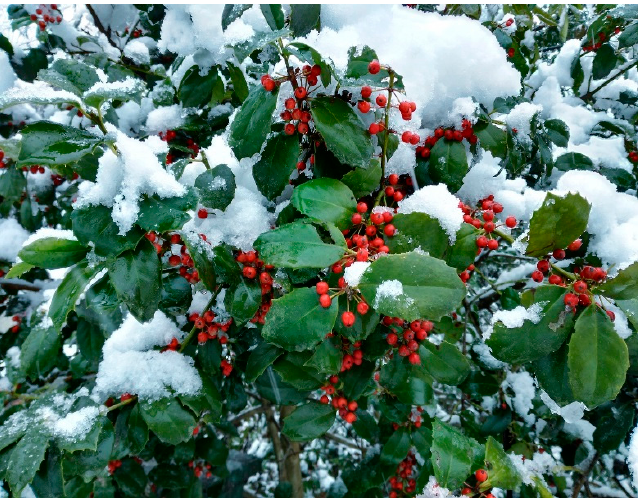
Figure 1. I. dabieshanensis in the snow.